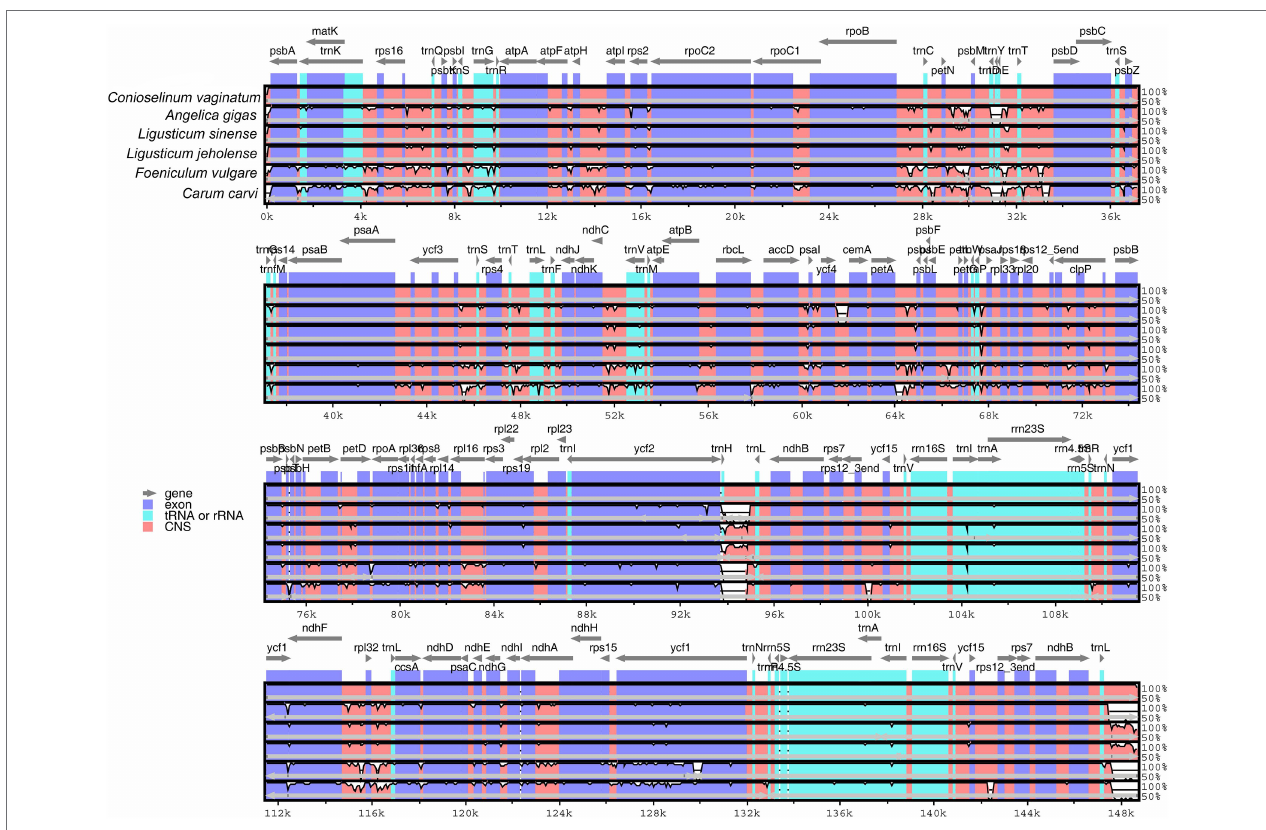
FIGURE 6 | Sequence identity plot comparing the five chloroplast genomes with Conioselinum vaginatum as a reference by using mVISTA. Gray arrows and thick black lines above the alignment indicate genes with their orientation and the position of the inverted repeats (IRs), respectively. A cut-off of 70% identity was used for the plots, and the Y -scale represents the percent identity ranging from 50 to